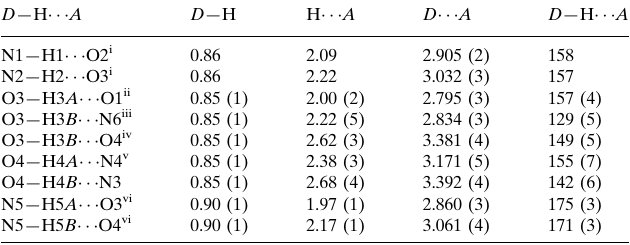
Hydrogen-bond geometry (A˚ , (cid:2)